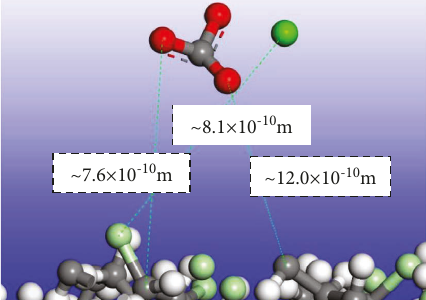
Figure 8: Interaction between calcium and PVC.